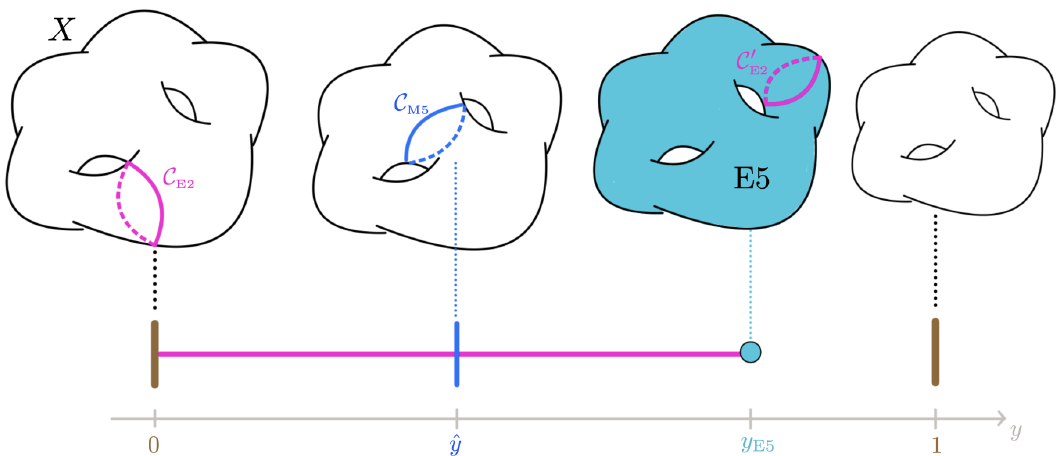
Figure 1 . BPS instantons in E 8 × E 8 heterotic models . The internal seven-dimensional space is a fibration of the Calabi-Yau X over the horizontal M-theory interval I = { 0 ≤ y ≤ 1 } . The vertical brown and blue lines denote the HW walls and a background M5-brane wrapping the internal curve C , respectively. The picture includes a Euclidean M5/M2-instanton: the light blue Euclidean M5 M5-brane (E5) sits at a given position y along I and wraps the entire internal Calabi-Yau space. E5 It is connected to the left HW wall by two purple Euclidean M2-branes (E2) wrapping C respectively, such that C 0 ' C + C , which reconnect on the bulk M5-brane. See also appendix D E2 M5 E2 for further